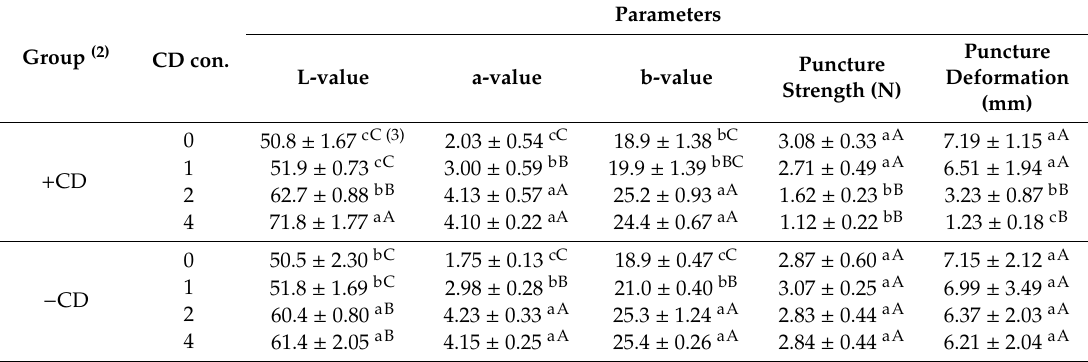
(CD) concentrations (1).